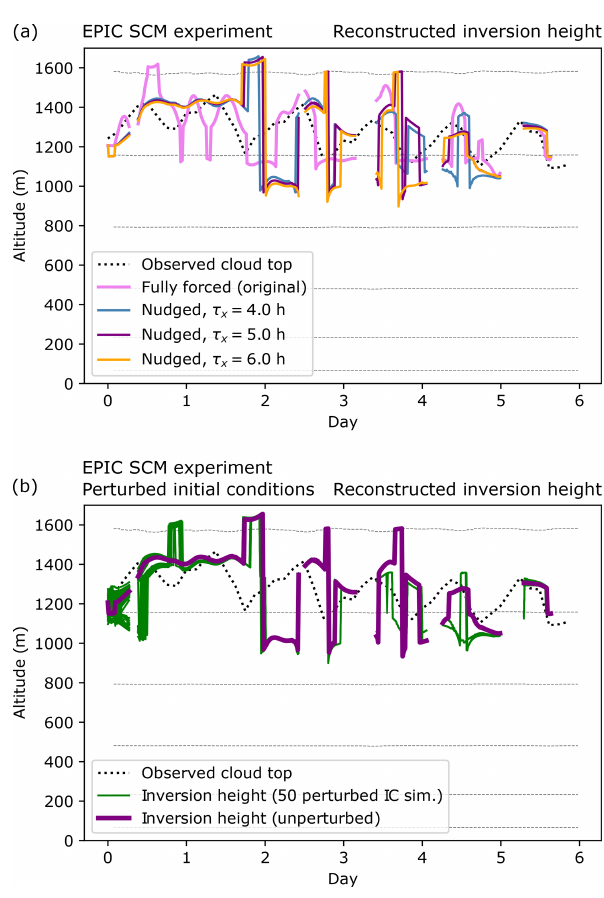
Figure B1. Reconstructed inversion heights in modified EPIC SCM experiments (a) with different nudging relaxation timescales τ x and (b) with τ x = 5h and perturbed initial